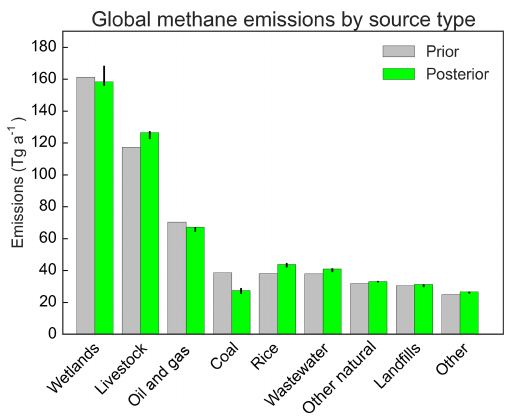
Figure 5. Global methane emissions by source type in the prior esti- mate for the inversion (Table 1, “other” includes fossil fuel combus- tion, industrial processes, and agricultural field burning) and in the posterior estimate. Values are 2010–2015 means. The attribution to source types in the posterior estimate is done by assuming that the relative contributions of different source types in individual 4 ◦ × 5 ◦ grid cells are correct in the prior estimate. Posterior estimates are from the base inversion, and error bars show the ranges of results from the inversion ensemble.